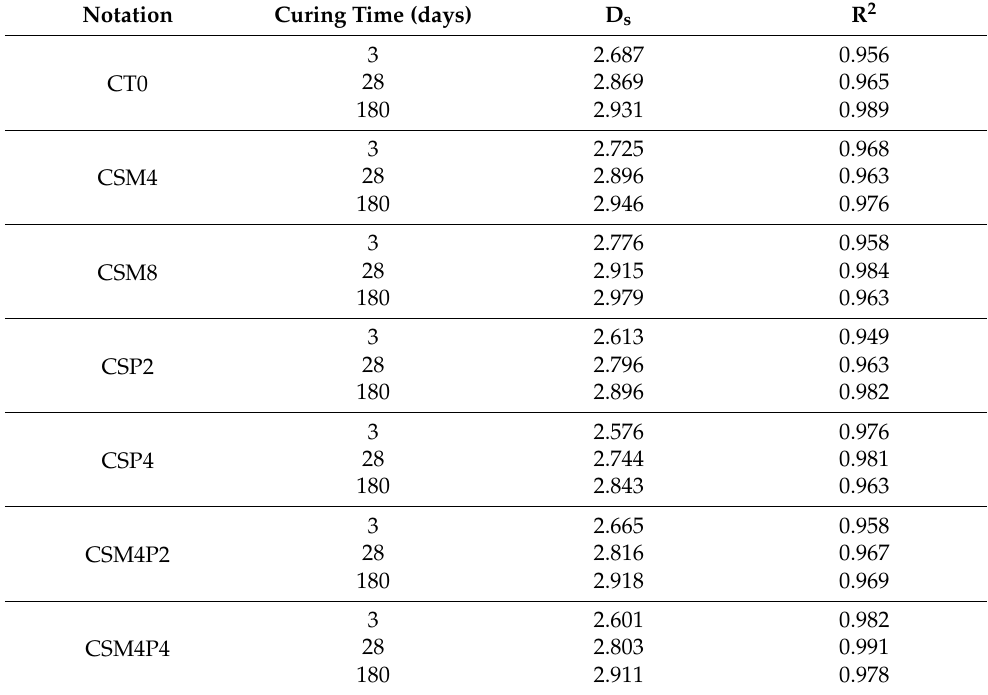
Table 8. Pore surface fractal dimensions of hydraulic concretes containing MgO and/or PVA fiber.